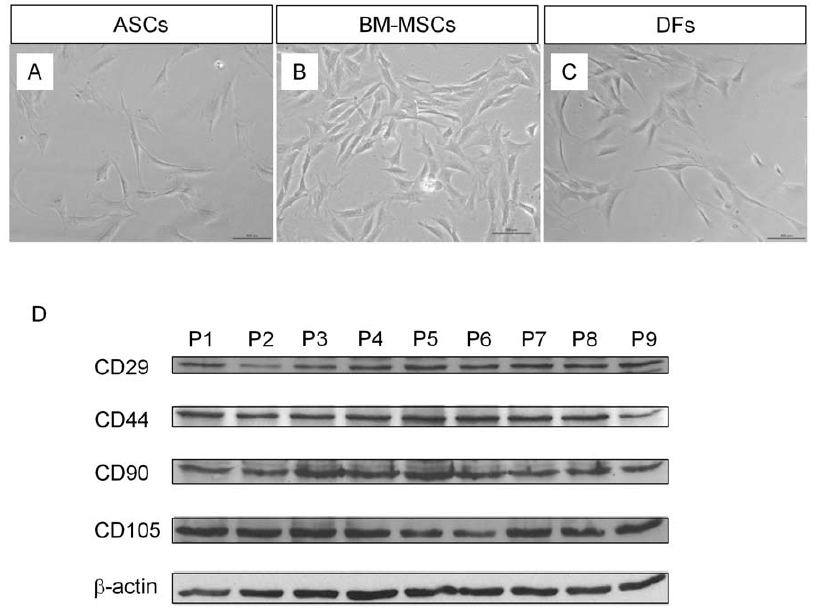
Figure 1. Morphology and surface markers of rabbit MSCs. (A–C): Bright field images of rabbit ASCs (A), BM-MSCs (B), and DFs (C). Cells were grown in culture dishes with growth medium and photos were taken. Scale bar; 100 m m. (D): Western blot analysis. Whole cell extract of rabbit ASCs from passage 1 (P1) to P9 was prepared and loaded 20 m g per well. The expression of CD29, CD44, CD90, and CD105 were detected with their specific antibodies as indicated. b -actin was detected as a loading control.